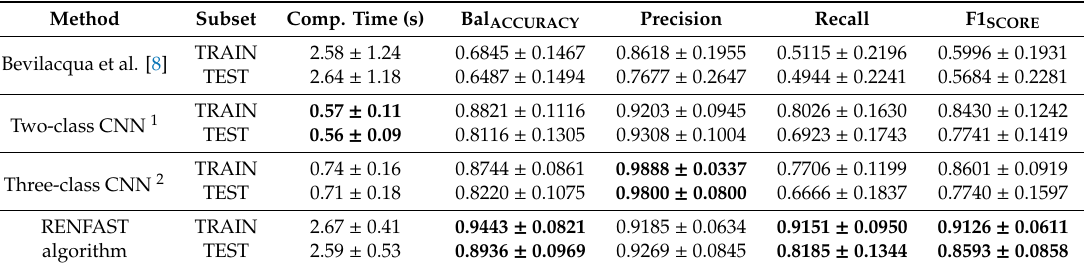
Table 2. Comparison between the RENFAST algorithm and the current state of the art for blood vessel segmentation (pixel-based metrics).